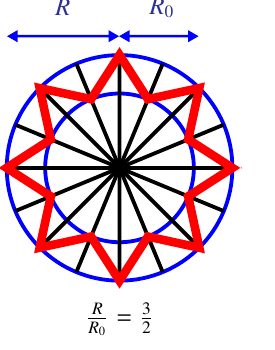
Figure 2. Design of the grains (in red) cut in Plexiglas. Two concentric circles are drawn, the outer one with a radius R and the inner one with a radius R 0 . The grains are then octagonal stars inscribed between these two circles. The higher the radius ratio, the higher the irregularity of the grains. The surface of the grain is kept constant for each shape.